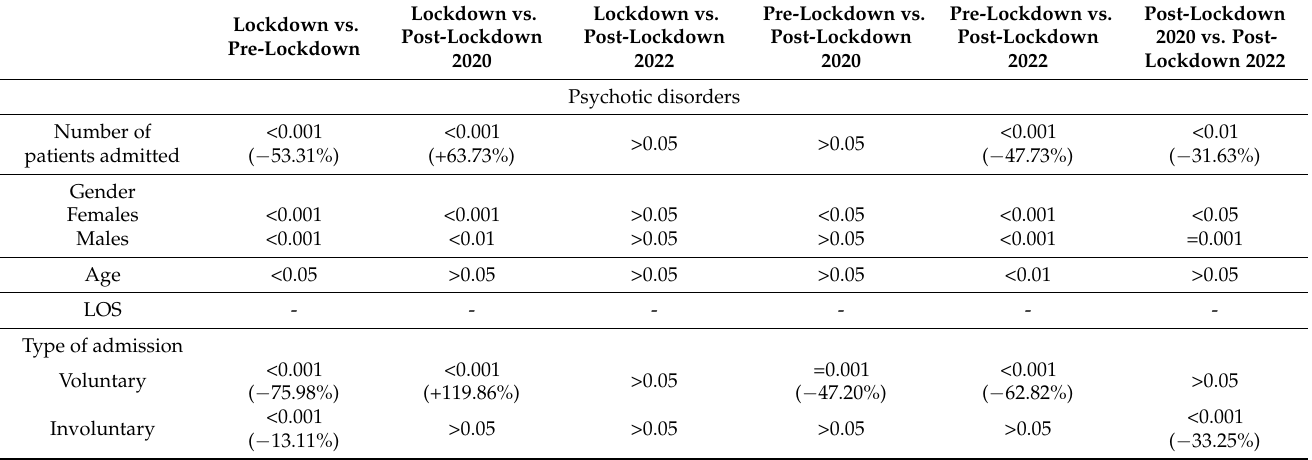
Table 2. Comparison of the socio-demographic, clinical, and administrative variables of the psychotic disorder and affective disorder groups between the respective time